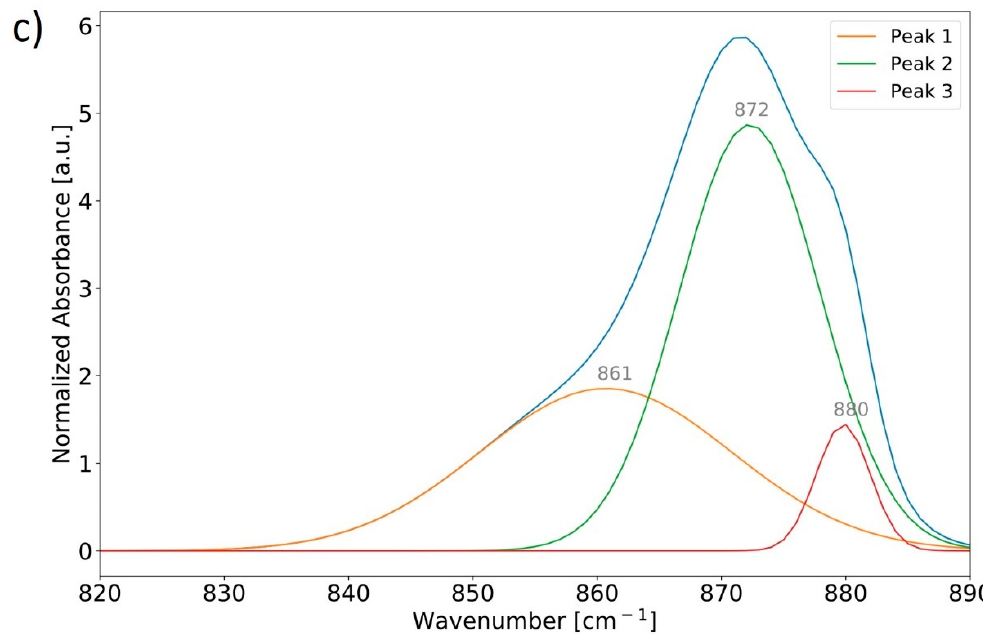
Figure 5. Normalized ATR-FTIR spectra of powderized bone samples from the ABM sectioned from 450–2000 cm − 1 for ease of viewing ( a ). Important chemical parameters can be characterized by integrating and comparing characteristic absorption bands relating to the mineral and organic content of the bone. Absorption bands are approximated from peak fitting using a residuals-based method for characteristic ν 2 carbonate (yellow), phosphate (blue), and amide I (dark orange) absorption band regions. The ν 2 carbonate and phosphate band regions are more clearly visualized over the range 820–1200 cm − 1 ( b ). Absorption band regions were deconvoluted using a residuals-based peak-fitting method to identify their constituent bands; an example is provided ( c ) for the ν 2 carbonate band region in the ATR-FTIR spectrum of bone material from the ABM calcaneus.